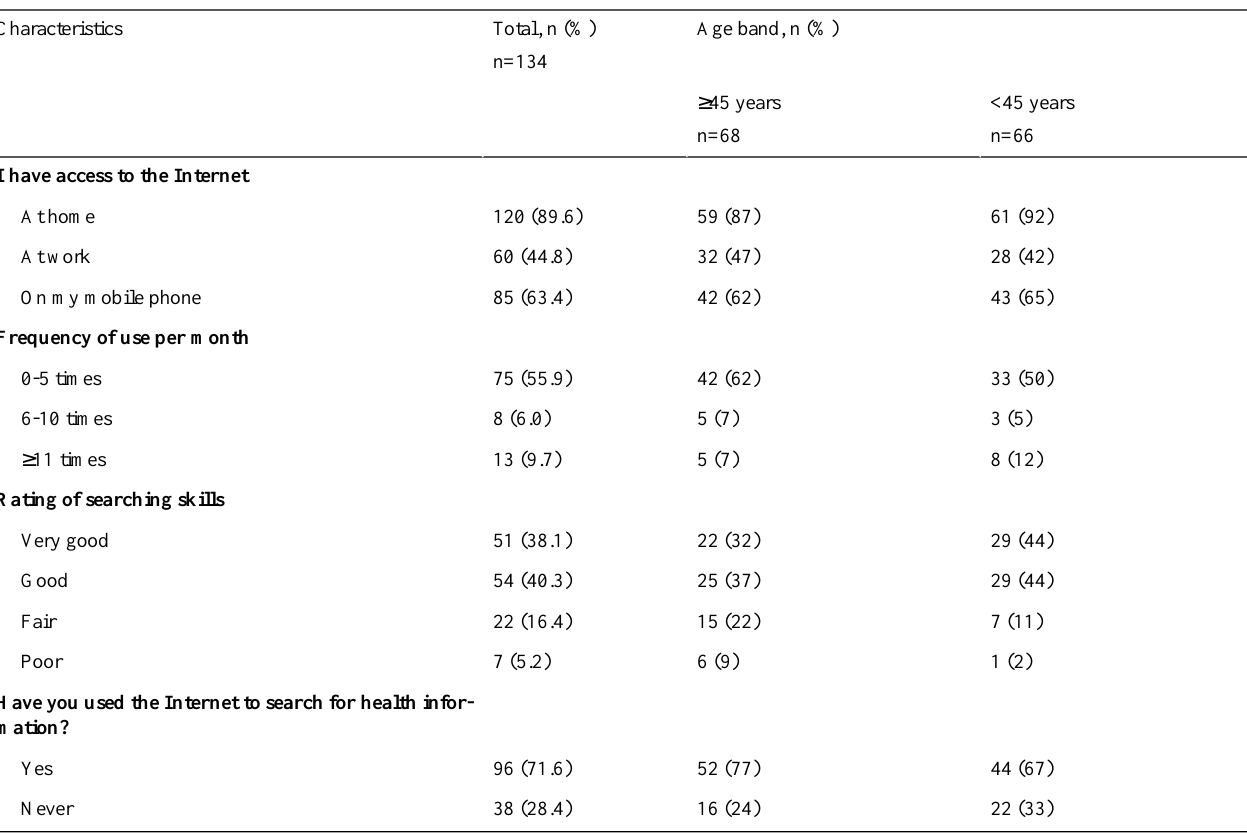
Table 2. Characteristics of Internet users included in the